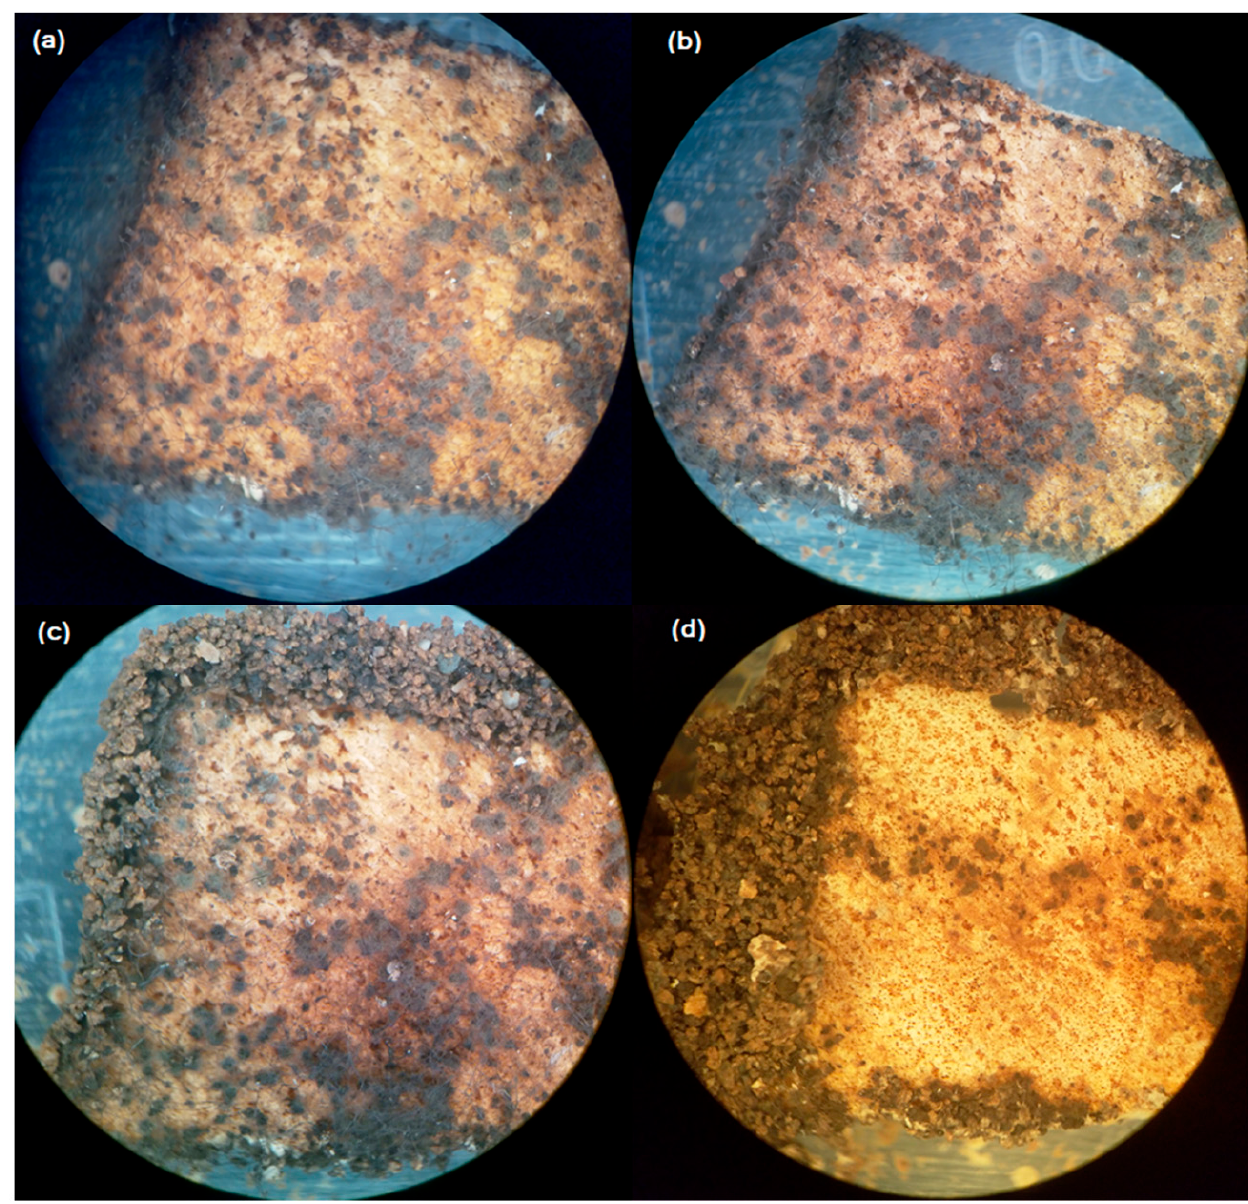
Figure 1. Progressive degradation of fungal colonies by Reticulitermes grassei on colonized wood substrates under laboratory conditions. ( a ) At the beginning of the experiment, and at ( b ) 24 h, ( c ) 48 h, and ( d ) 120 h after wood exposure to R. grassei in hermetic plastic containers. Please note the margins of the wood block covered with vermiculite by the activity of termites at 48 and 120 h after wood exposure to R. grassei